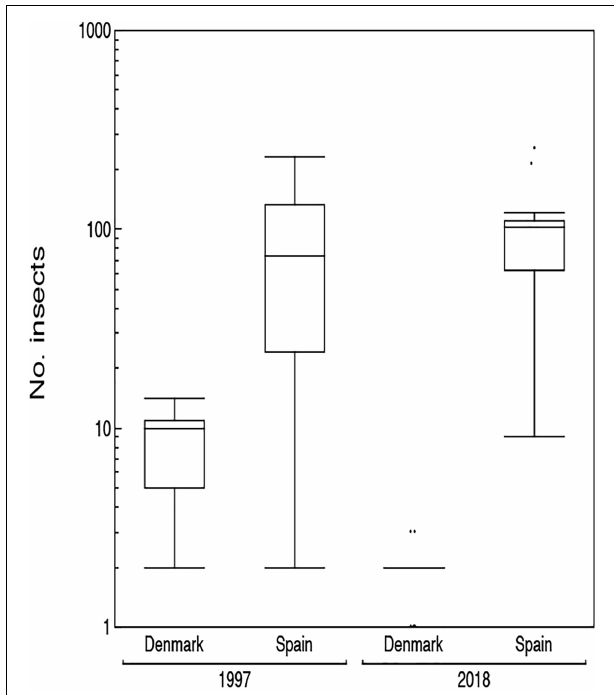
FIGURE 5 | Box plots of the number of insects sampled with a car for Denmark and Spain in 1997 and 2018. The box plots show median, quartiles, 5- and 95-percentiles and extreme values. Observations are jittered to make them visible.